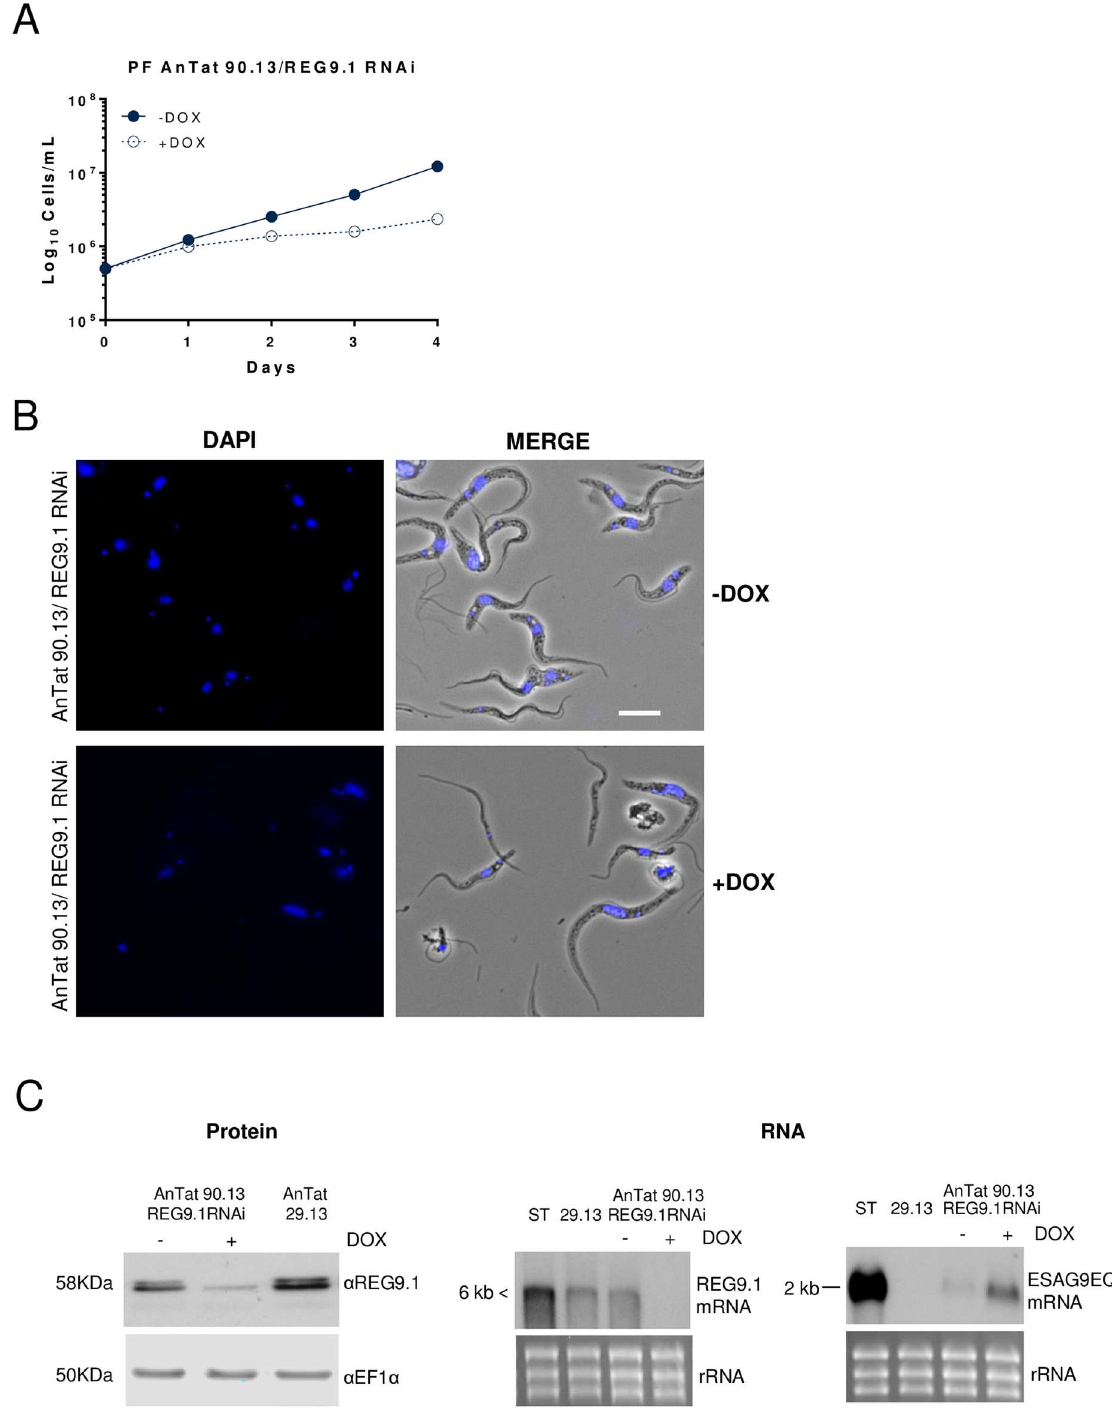
Fig 6. REG9 . 1 RNAi in procyclic forms. A. Growth of procyclic form AnTat1.1 90:13 RNAi lines inducedand uninducedto deplete REG9 . 1 . B. Morphologyof T . brucei AnTat 90:13 procyclic form REG9 . 1 RNAi lines, inducedand uninduced. DAPI stained and phase-contrast/DAPI stainedcells (‘Merge’)are shown. Bar = 10 μ m.C. On the left panel is shown a Western blot of REG9.1 in AnTat1.1 90:13 procyclic forms whetherinducedor not to deplete REG9 . 1 transcript by RNAi for 96 h. Established T . brucei AnTat 29:13 procyclic forms were used as a control; the loadingcontrol was an antibodydetecting EF1 α . On the right are northernblots of REG9 . 1 and ESAG9-EQ mRNAs in stumpy forms, procyclicAnTat1.1 29:13 control cells and the AnTat1.1 90:13